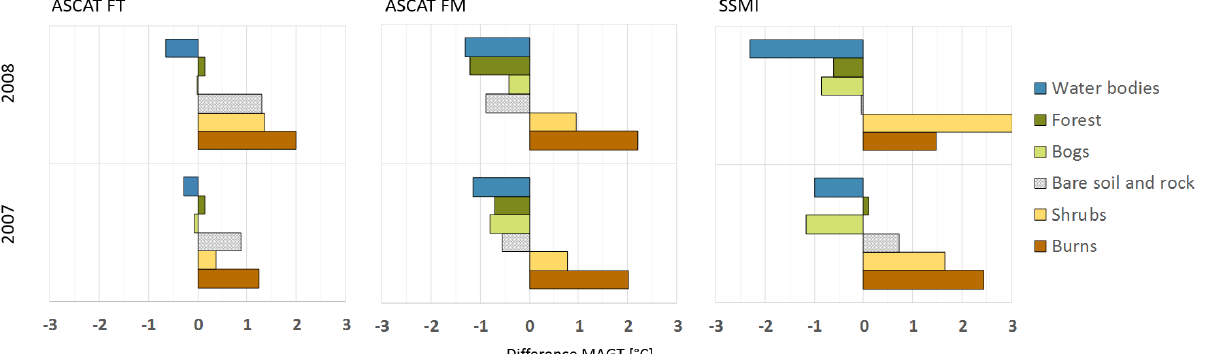
Figure 10. Difference between modelled MAGT c and in situ MAGT c (coldest sensor) by land cover type (source is GLC2000, 2003) in 2007/2008 and 2008/2009. FT – days identified as frozen without melting snow are used; FM – days with melting snow are considered to be frozen ground in ASCAT. Note that the class “burns” contains only two samples in all cases (“Amboliha 4 07” and “Shimanovskaya” in the northern and southern Russian Far East,